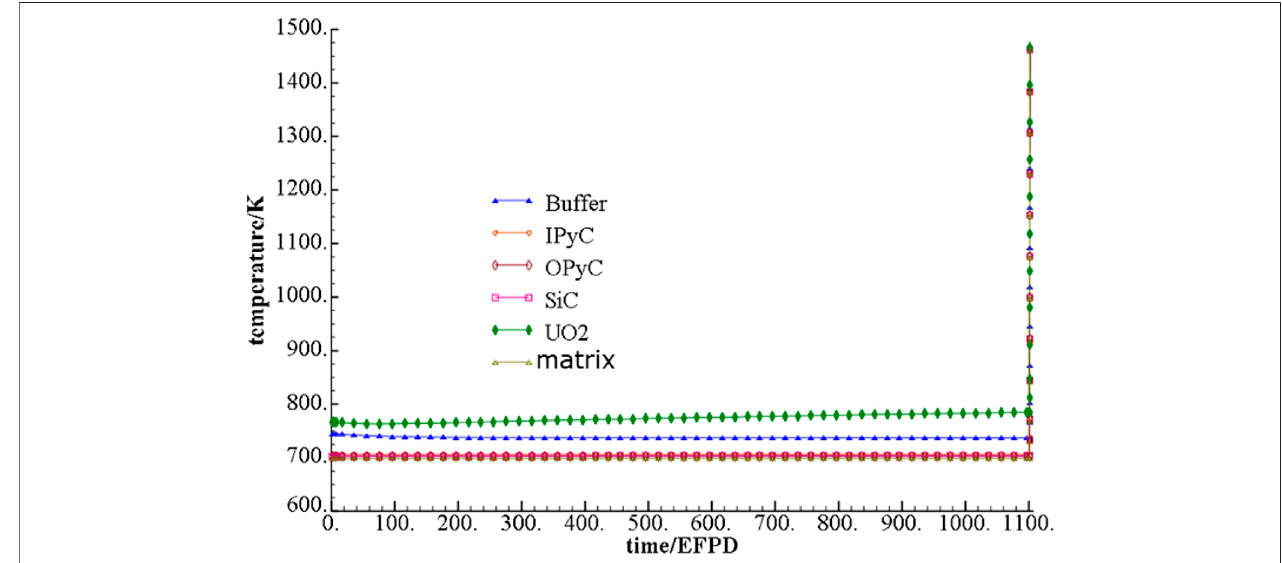
FIGURE 6 | Max temperature of each layer of material variation under steady operation condition and LOCA condition.